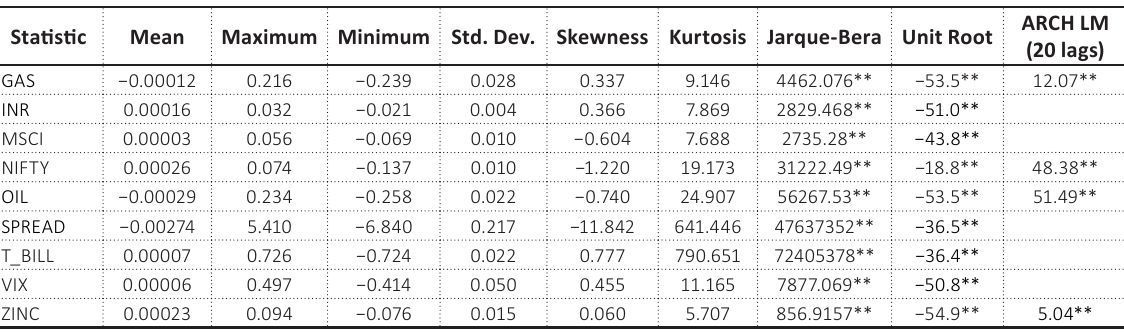
Table 2. Descriptive statistics